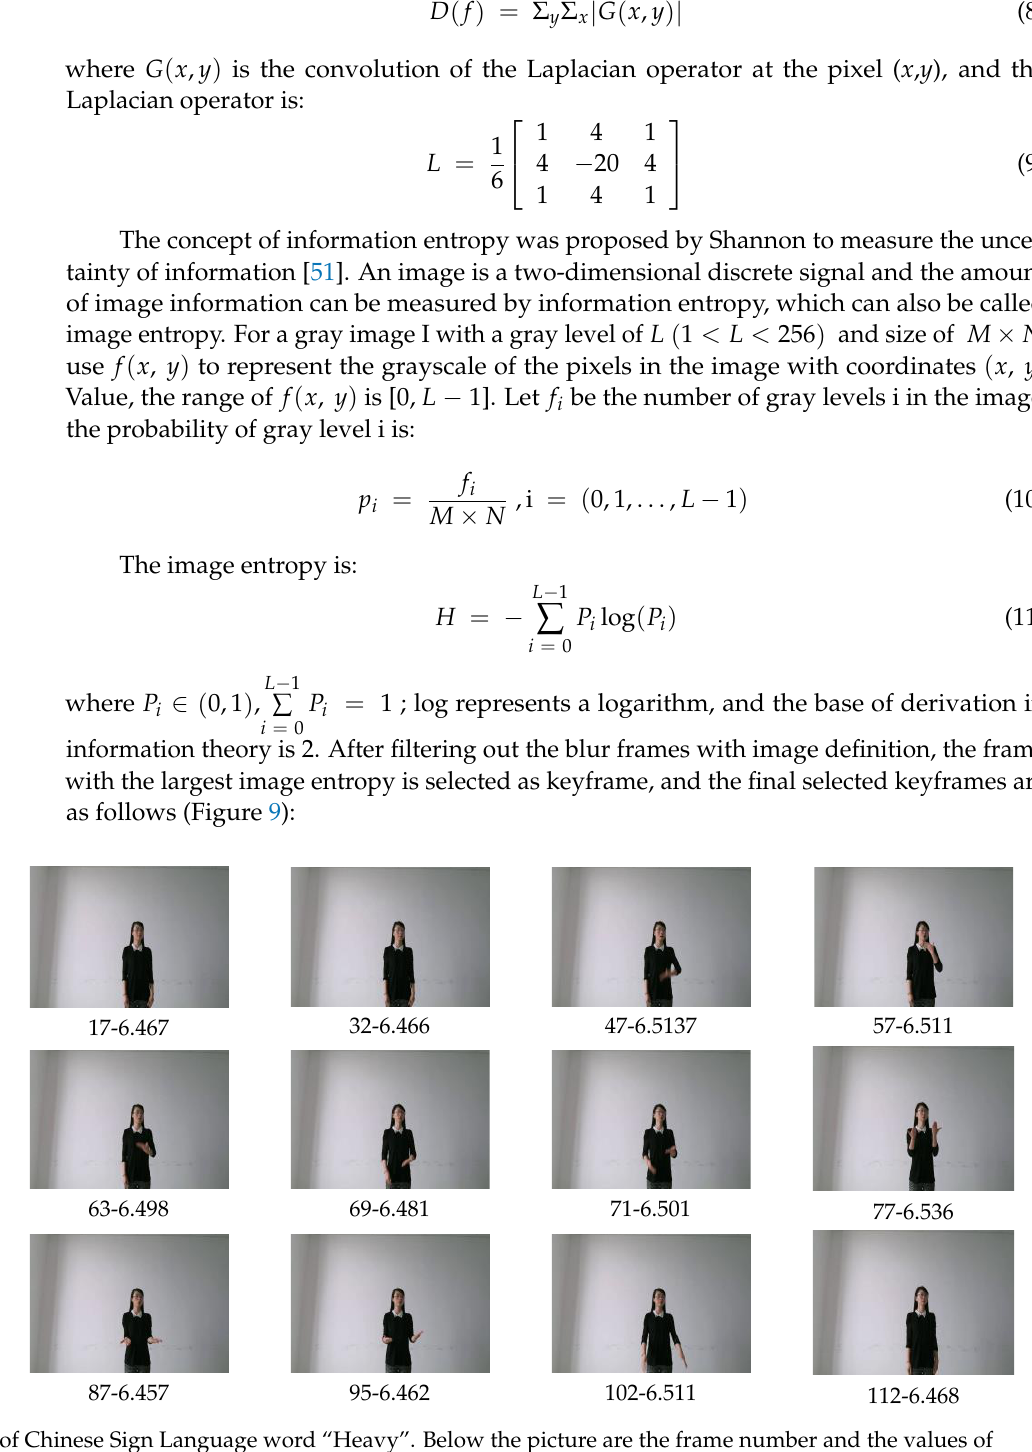
( c ) Figure 10. Skeleton data normalization example. ( a ) Benchmark sign language speaker; ( b ) Joints data before normaliza- tion; ( c ) Joints data after normalization.